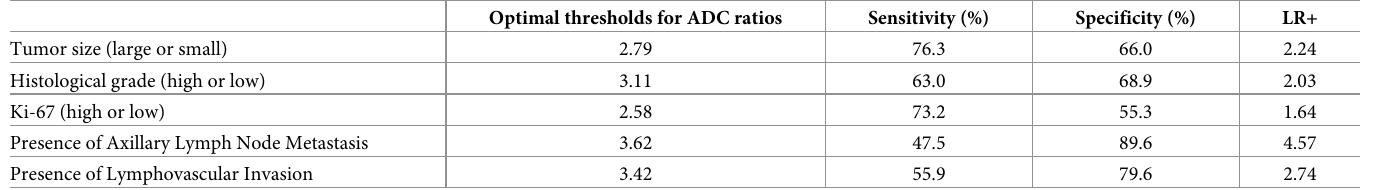
Table 5. Diagnostic performance of the peritumor/Tumor ADC ratios in prediction of histopathological parameters: Optimal thresholds for peritumor/Tumor ADC ratios, sensitivity, specificity and positive Likelihood Ratio (LR+). Optimal thresholds for ADC ratios